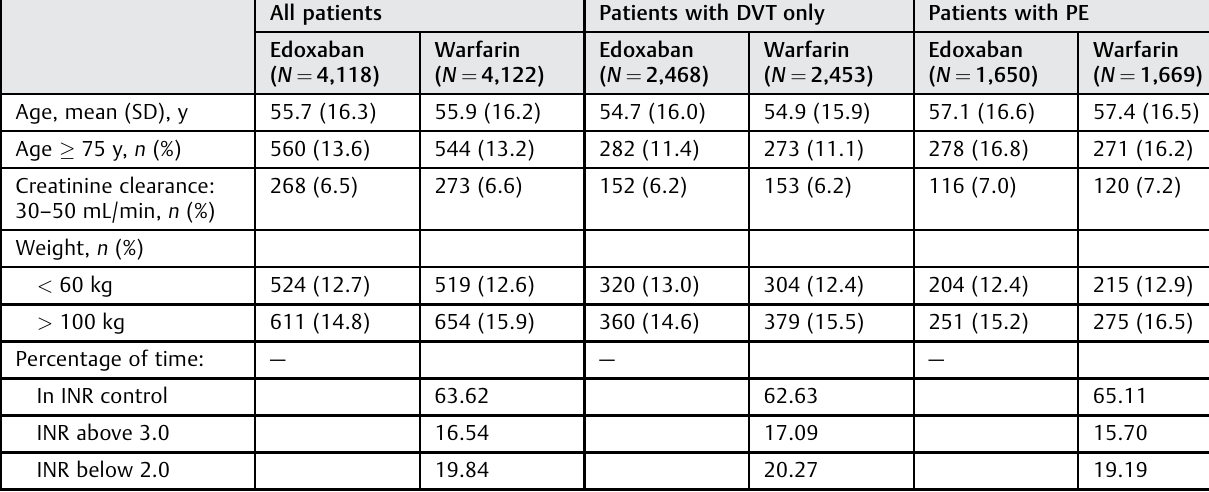
All patients Patients with DVT